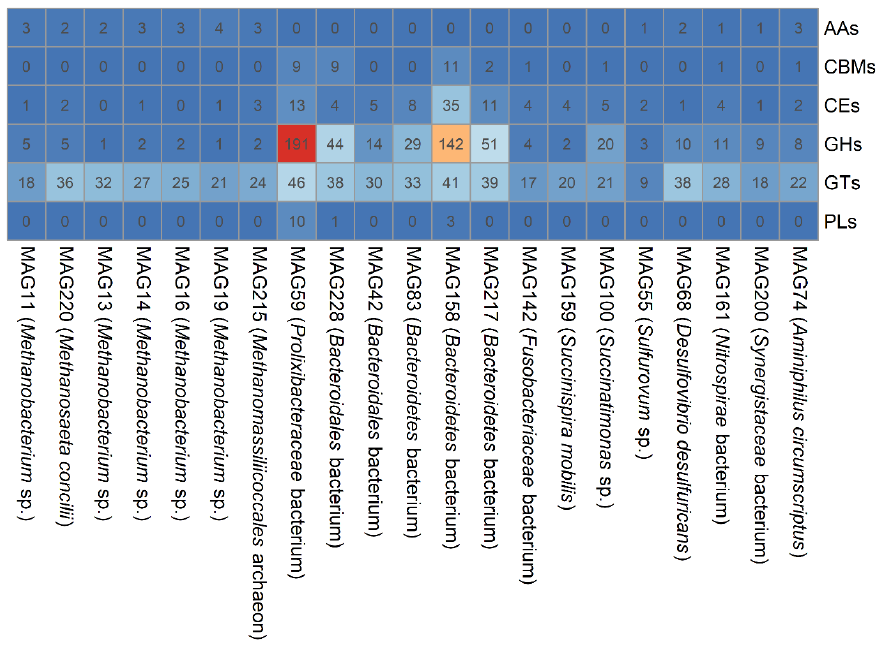
Figure 4. Numbers of genes associated with CAZyme in bacterial and archaeal MAGs.